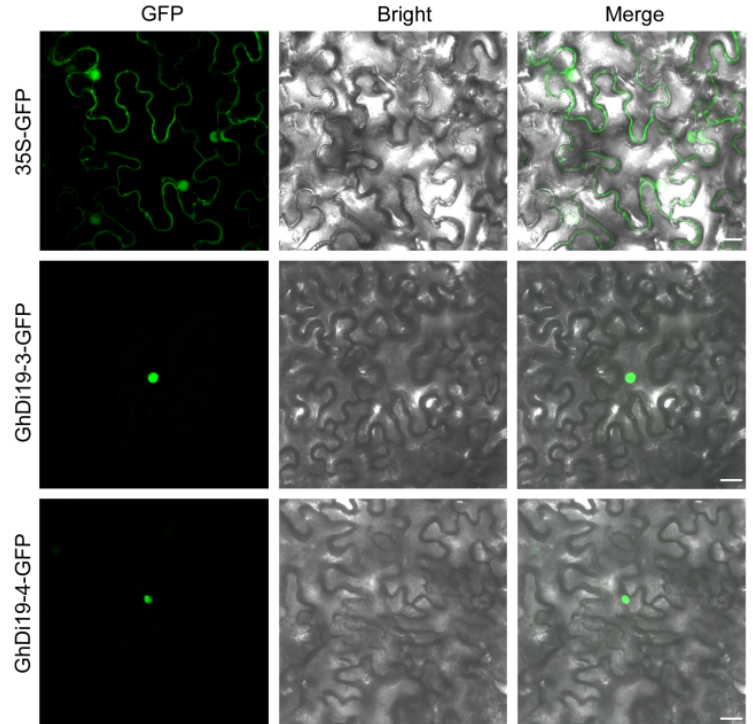
Figure 5. Subcellular localization of GhDi19-3 and GhDi19-4 in tobacco epidermal cells. 35S-GFP, GhDi19-3-GFP, and GhDi19-4-GFP represented confocal imaging of epidermal cells of transiently expression of the control GFP, GhDi19-3 and GhDi19-4, respectively. GFP fluorescence signals were mainly detected in nucleus of the tobacco epidermal cells. GFP, GFP fluorescence images; Bright, bright field image of the same leaf on the left; Merged, GFP fluorescence and bright merged image of the same leaf. Scale bars are 25 µm.